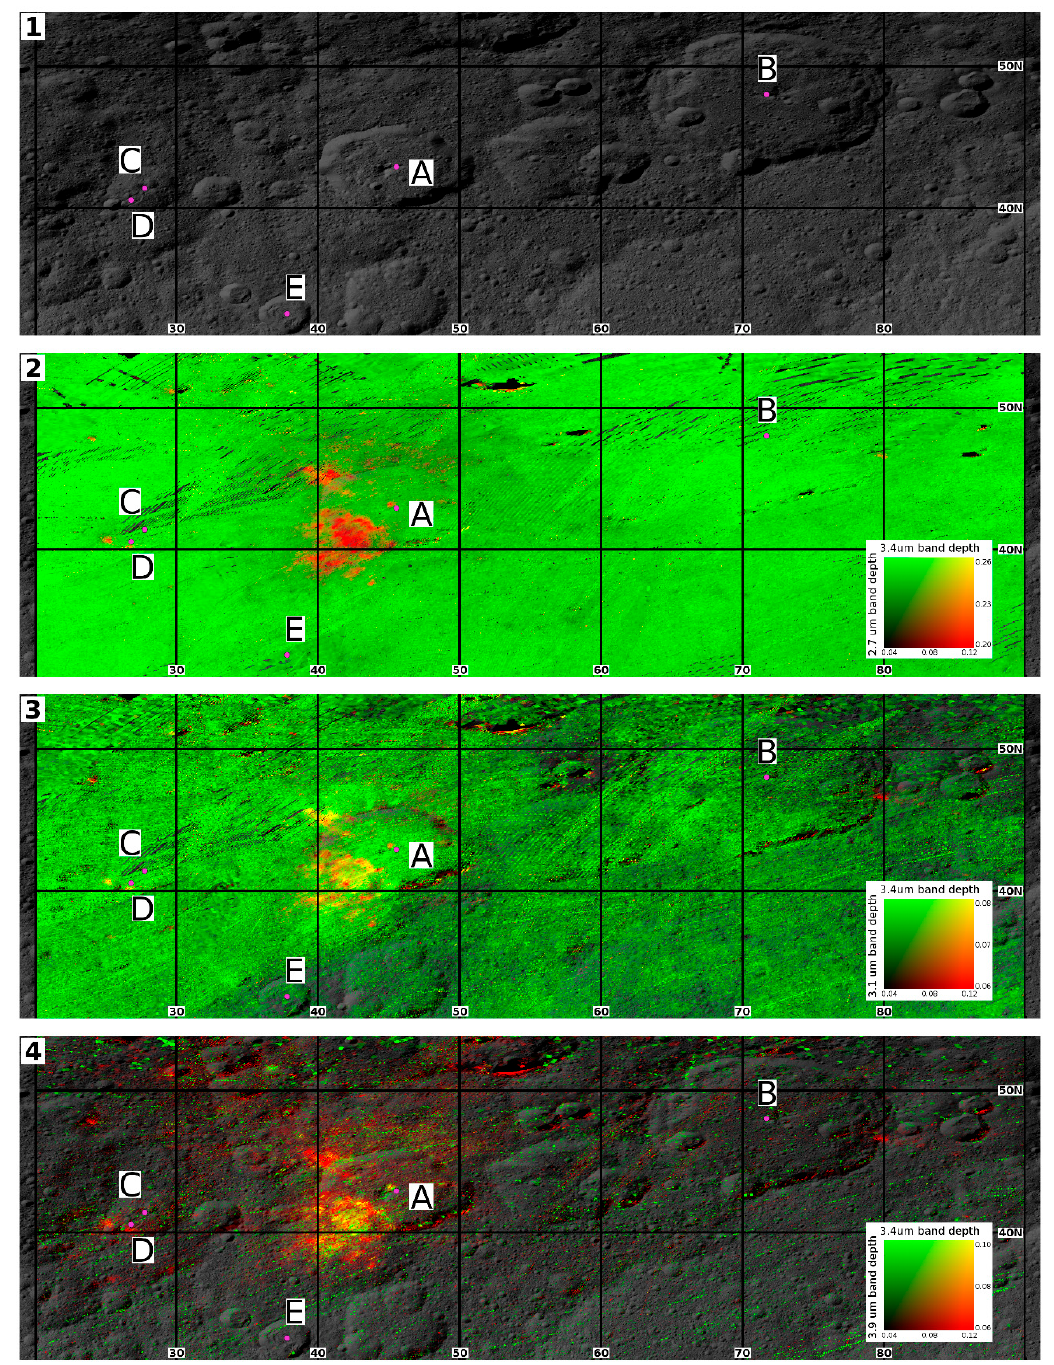
Figure 4. Interaction between the 3.4 µ m band (organics) with other mineral phases identified on Ceres (i.e., phyllosilicates (2.7 µ m band), ammoniated phases (3.06 µ m band), carbonates (3.9 µ m band)) in the Ernutet region. 1: clear filter mosaic; 2: abundances of organics in red and phyllosilicates in green; 3: abundances of organics in red and ammoniated phases in green; 4: abundances of organics in red and carbonates in green. Ranges are 0.20–0.26 for 2.7 µ m band depth, 0.06–0.08 for 3.1 µ m band depth, 0.04–0.12 for 3.4 µ m band depth, 0.06–0.10 for 3.9 µ m band depth. Morphological features in the figure are: A: Ernutet crater, B: Omonga crater, C: Hakumyi crater, D: Sukkot Labes, E: Liber crater.